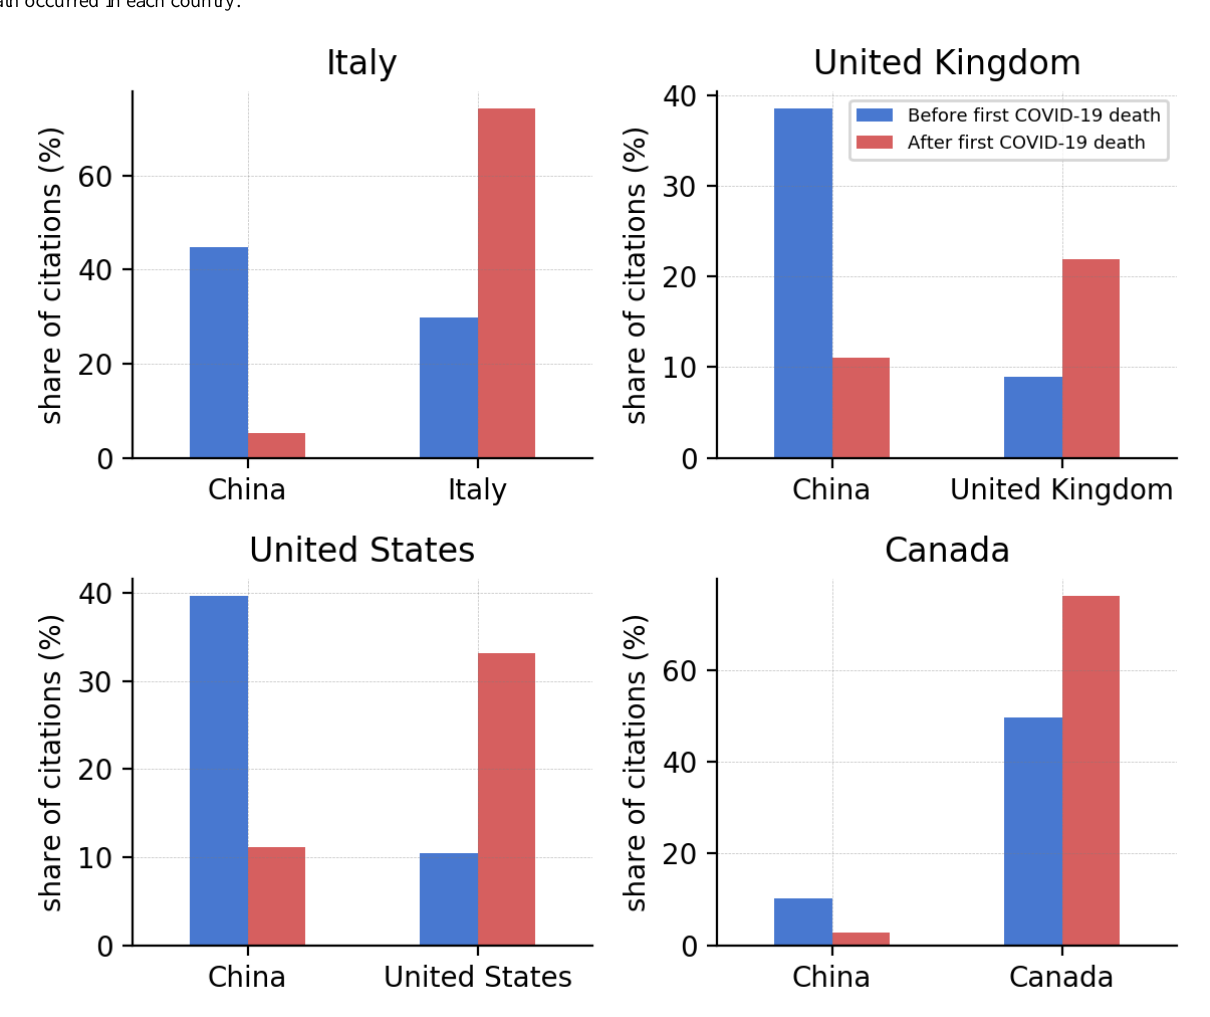
Figure 2. Shares of citations of China versus home country locations by Italian, UK, US, and Canadian news outlets before and after the first COVID-19 death occurred in each country.